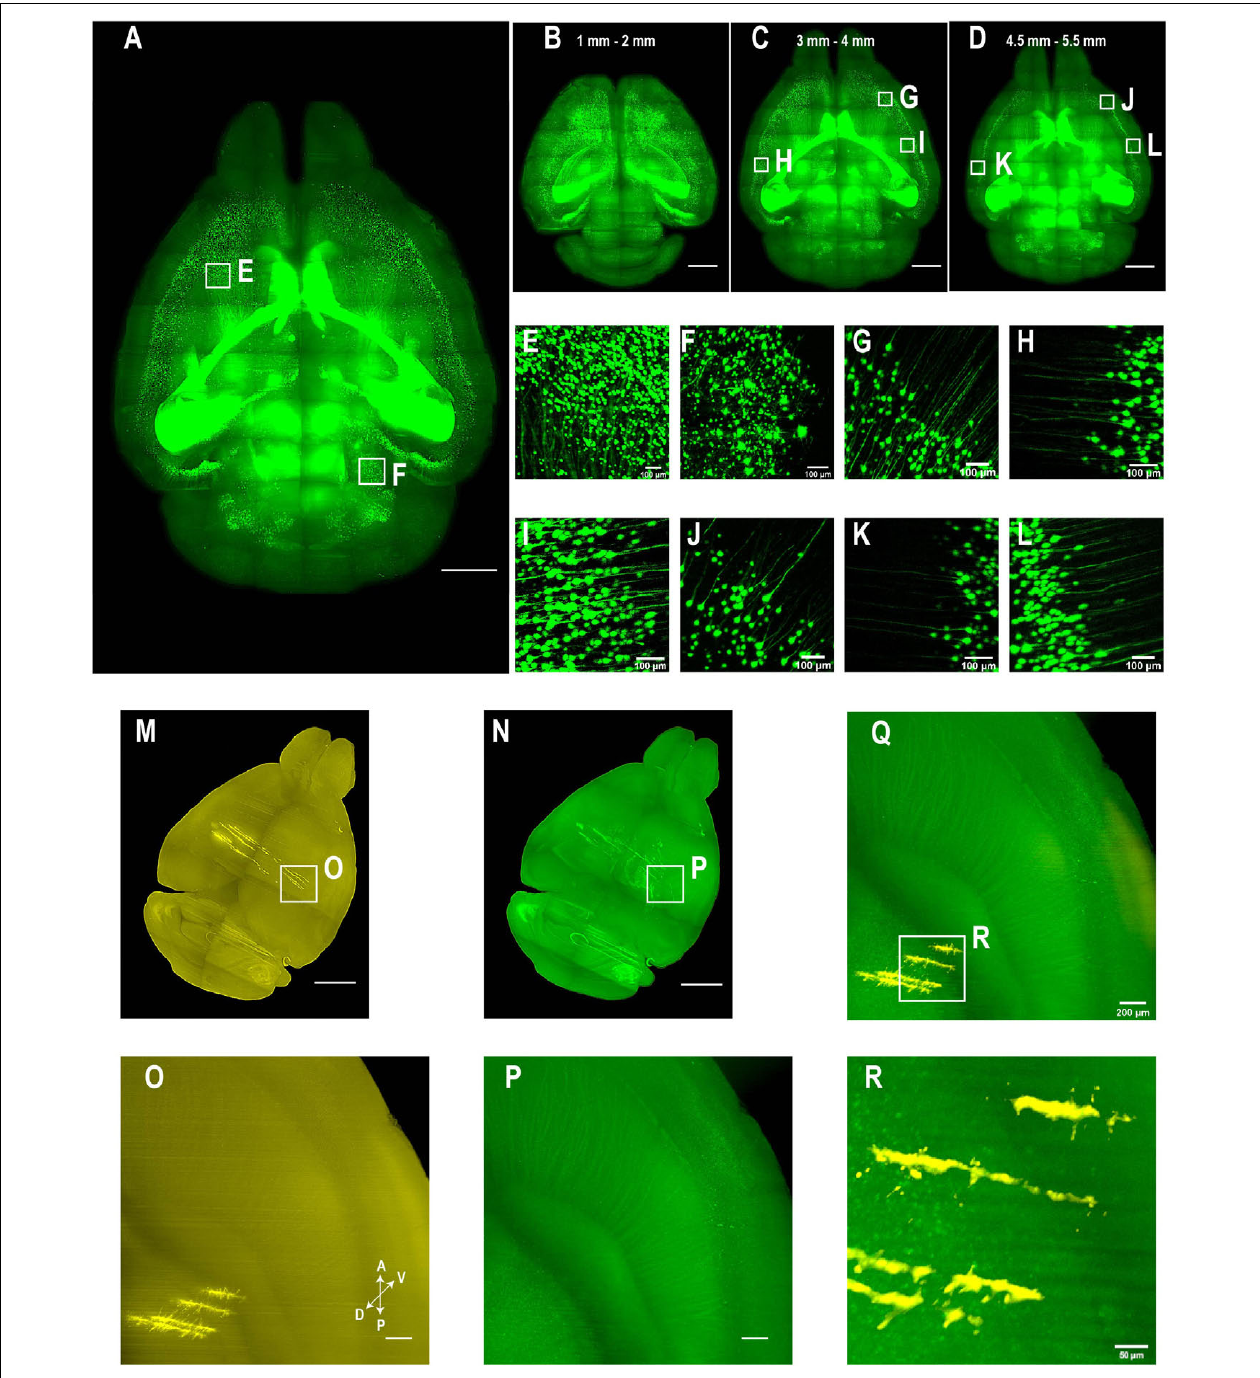
FIGURE 5 | Whole brain imaging of CUBIC-X- and uDISCO-cleared brains without cutting. (A–L) Whole brain imaging of a Thy1-EYFP-H transgenic mouse brain cleared by CUBIC followed by MACS RI matching. (A) 3D rendering of LSFM images of a cleared Thy1-EYFP-H brain. Similar results in the n = 3 samples. (B–D) MIPs of horizontal sections at (B) 1–2 mm, (C) 3–4 mm, or (D) 4.5–5.5 mm depth. (E,F) Zoomed-in view of boxed regions in (A) . (G–I) Zoomed-in view of boxed regions in (C) . Imaging depth, 3–4 mm. (J–L) Zoomed-in view of boxed regions in (D) . Imaging depth, 4.5–5.5 mm. (M–R) Two-color imaging of uDISCO-cleared brains allows reconstruction of electrode recording locations. (M) Whole brain rendering of images acquired by 561-nm excitation (yellow). To label electrode tracks, CM-DiI was painted on the four shanks of a silicon probe prior to insertion. Similar results in the n = 2 samples. (N) Autofluorescence in the green channel allows good visualization of anatomical features that facilitate whole brain registration to Allen CCF v3. (O) Zoomed-in view of the boxed region in (M) showing sharp traces of CM-DiI near electrode tips. (P) Same region as in (N) (green channel). (Q) Merged image of (O,P) shows electrode localization with anatomical features. (R) Zoomed-in view of the boxed region in (Q) . Scale bars, 2 mm (A–D) , 100 µ m (E–L) , 1 mm (M,N) , 200 µ m (O–Q) , 50 µ m (R) .